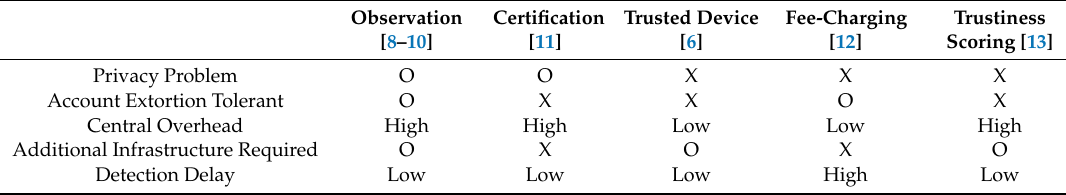
Table 1. Comparison for Sybil attack detection